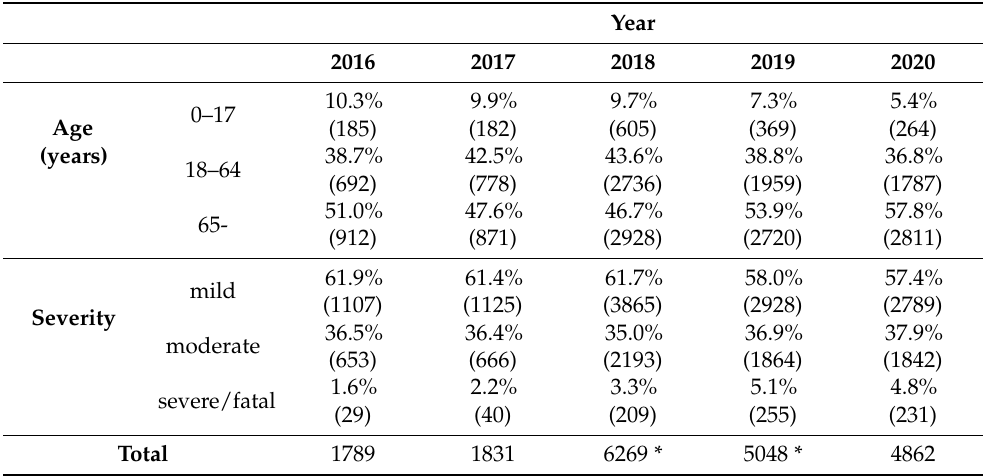
Figure 1. Number of coronavirus disease 2019 (COVID-19) admissions and Tokyo rule for emergency medical care in March–September 2020. Yellow bars illustrate the number of COVID-19 admissions, and the blue line presents the trend in the Tokyo rule for emergency medical care. Please note that the number of COVID-19 admissions before 11 May included patients isolated at designated accommodations or home, and the number of hospitalized COVID-19 patients before 5 March was not published on the dashboard [11]. Table 1. Number of emergency transportations due to heat illness in Tokyo in weeks 29–36 in Tokyo in 2016–2020, by age and